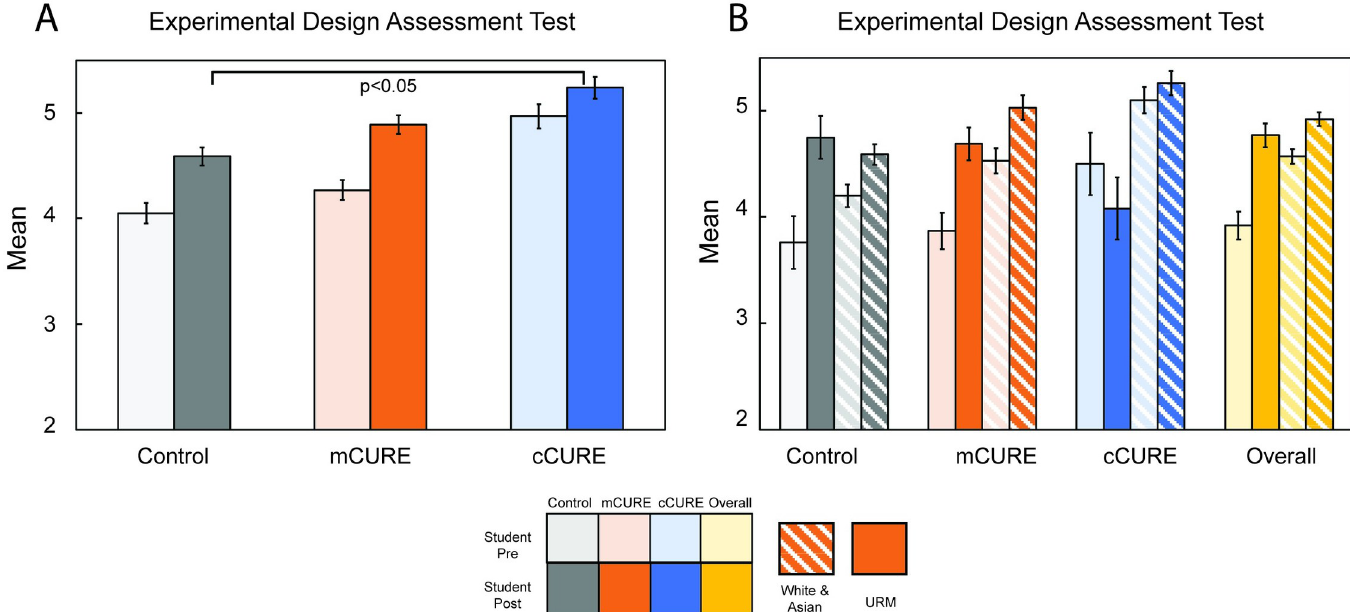
Fig 7. cCURE students score significantly higher on experimental design regardless of URM status. The experimental design assessment test (EDAT) [60] was given at the beginning and end of each semester. Responses were scored from 0 to 10 and an ANCOVA controlling for pretest scores was used to compare conditions. (A) Students in the cCUREs scored significantly higher than students in control courses, while students in the mCURE were not significantly different from either the control or cCURE students. (B) There was no significant difference in the performance of students by URM status within or between conditions. Statistical significance is represented as standard error (S.E.). See S11 Table for full